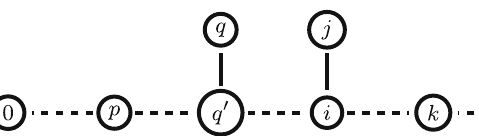
Figure 18: Minimum subgraph of C containing vertices {